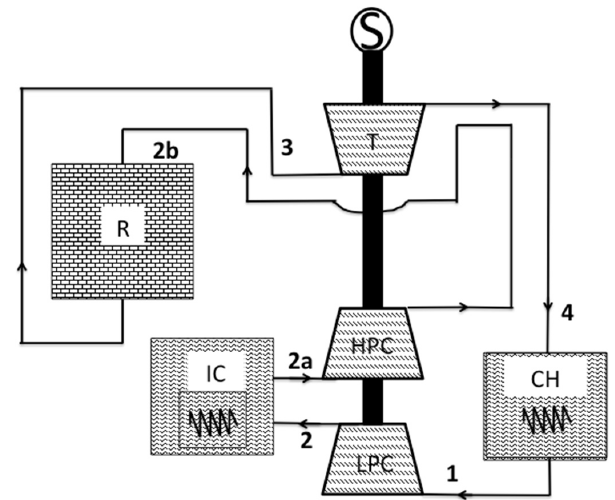
Figure 3. Typical Intercooled Cycle (IC) [9]. Single shaft spool connection to the turbomachinery, which includes an LPC, HPC, and turbine as part of the turbomachinery, precooler, intercooler, and reactor, but no recuperator. The schematic shows 6 stations (station 2 comprising 3 stations).